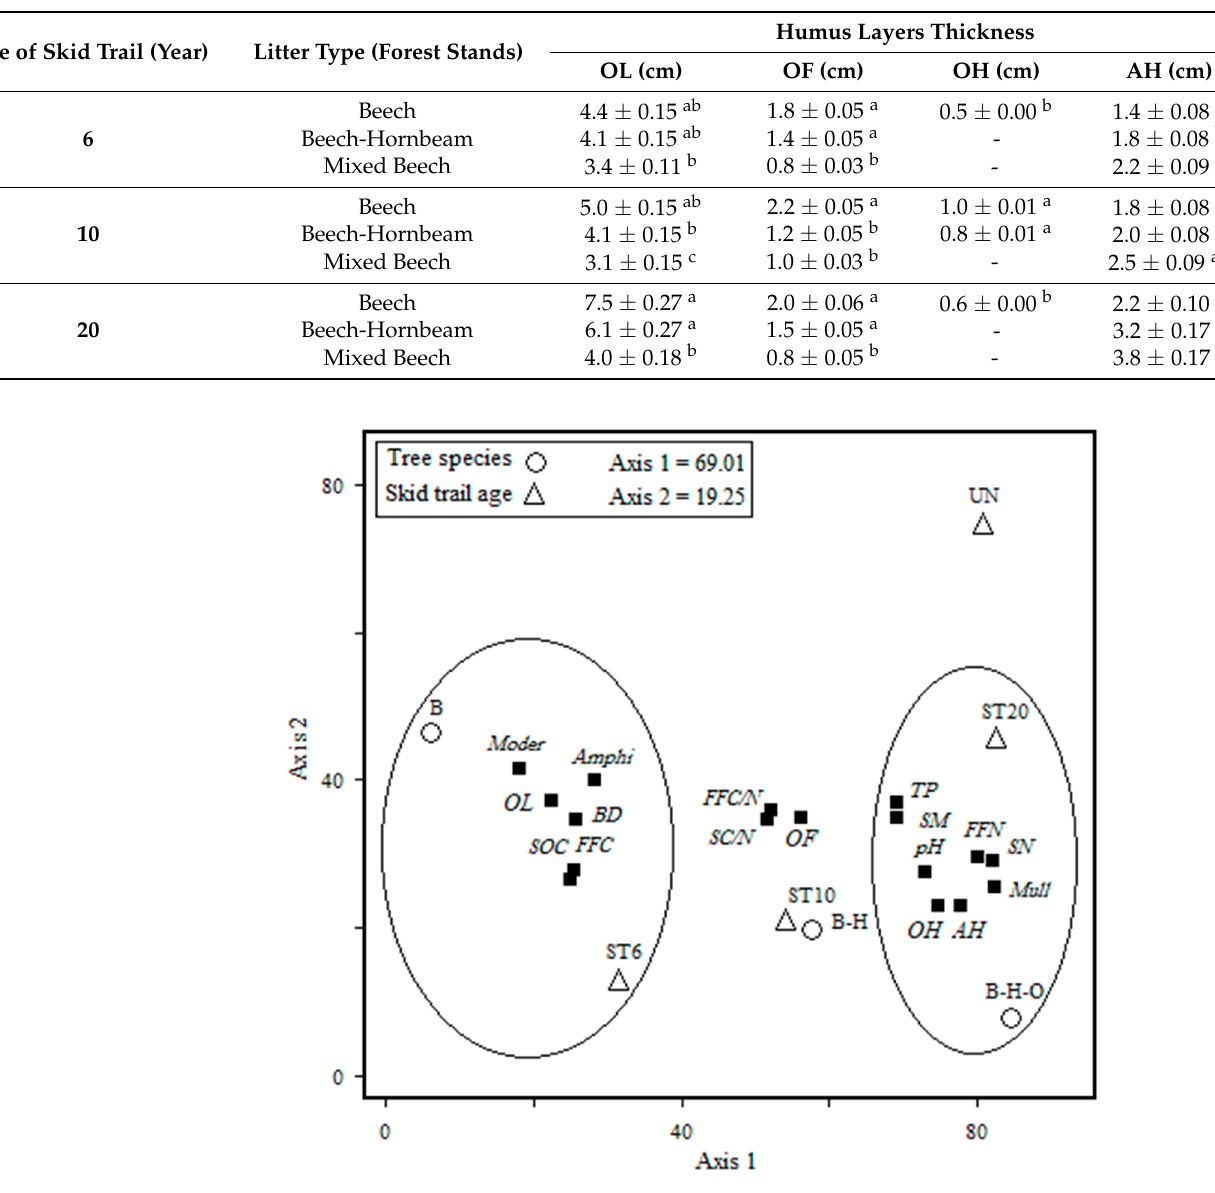
Figure 5. Principal component analysis (PCA) of the measured variables at various treatments; Litter type: B; Beech, B-H; Beech-Hornbeam, B-H-O; Mixed Beech; time since harvest: ST6; 6 years, ST10; 10 years, ST20; 20 years and UN: Undisturbed. Humus layers thickness (OL: Organic litter; OF: Or- ganic fragmentation; OH: Organic humus and AH: Organic-mineral layer), Forest floor properties (FFC: Forest floor carbon; FFN: Forest floor nitrogen and FFC/N: Forest floor C/N), Soil physical properties (SM: Soil moisture; BD: Bulk density and TP: Total porosity) and Soil chemical properties (SOC: Soil organic carbon, SN: Soil nitrogen and SC/N: Soil C/N).